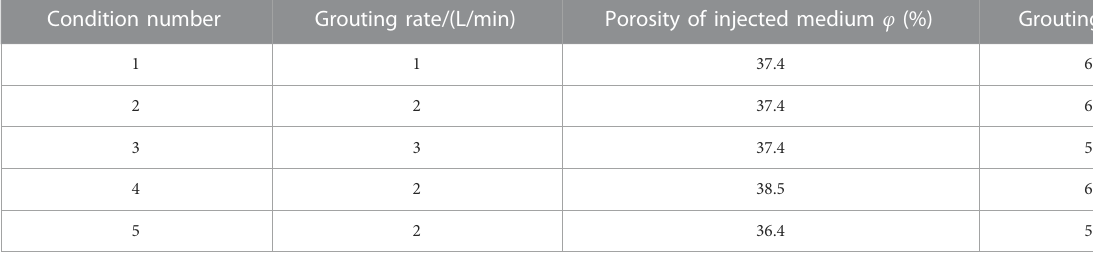
TABLE 2 Experiment